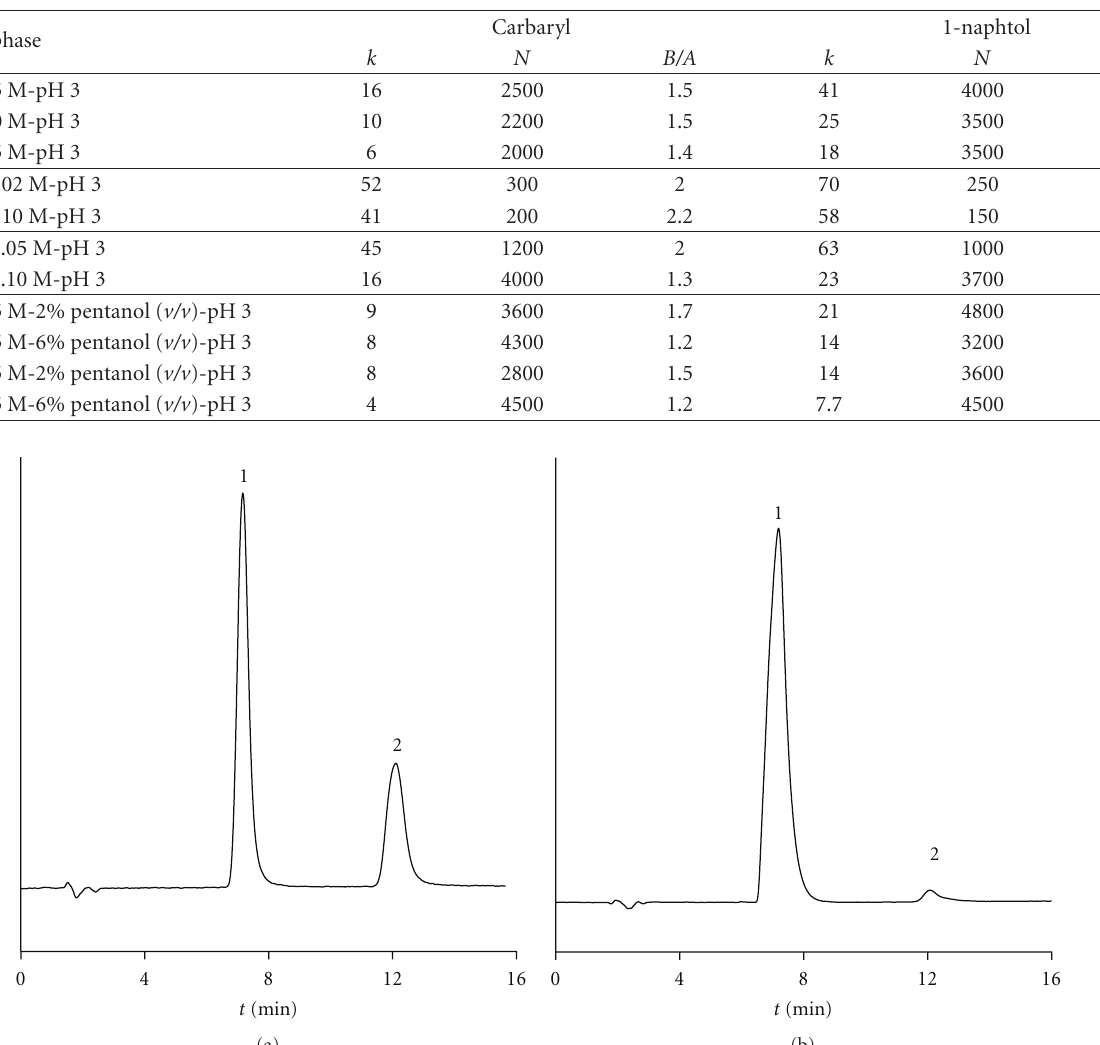
Table 1: Chromatographic parameters of the pesticides: retention factors ( k ), e ffi ciencies ( N ), and asymmetry factors ( B/A ) for carbaryl and 1-naphthol in selected micellar mobile phases at pH 3 containing di ff erent surfactants (SDS, NCPC, or Brij-35) in the absence or presence of the organic solvent pentanol.